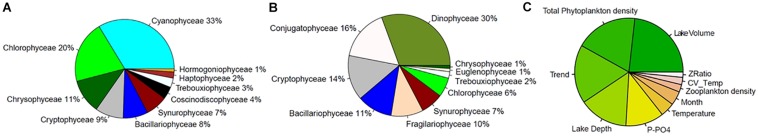
(A,B) Relative abundance of phytoplankton classes, expressed as a percentage, in the first (Smaller cells, A) and fourth (Larger cells, B) quartiles of the distribution of taxa biovolumes. Note that the color palette is consistent across the two charts, and not all groups are present in both size classes (e.g., Cyanophyceae). (C) Random forests ranking of predictors of SAR slopes over time and across lakes: the importance reflects the change in mean absolute error of the model when the variable of interest is permuted (the color gradient has no specific meaning, it is only for display).